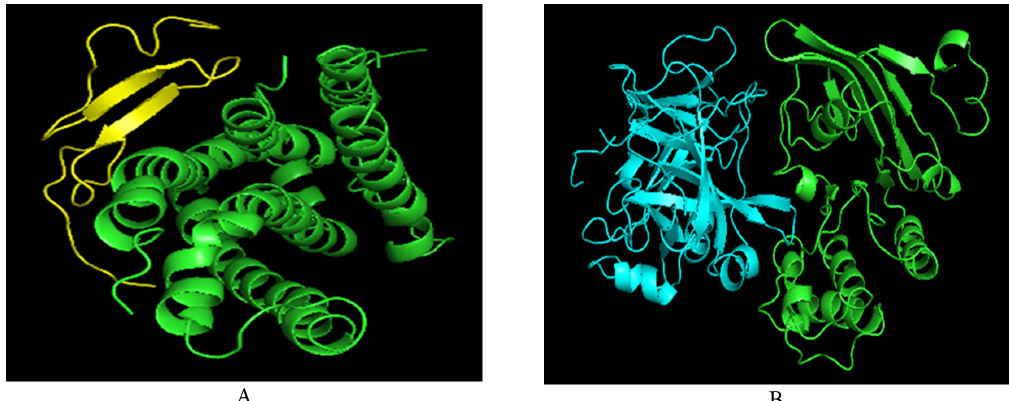
Figure 4. Escherichia coli lipopolysaccharide protein docking using PyMOL; (A) Escherichia coli lipopolysaccharide protein with coagulation factor VII (yellow); (B) Escherichia coli lipopolysaccharide protein with coagulation factor II